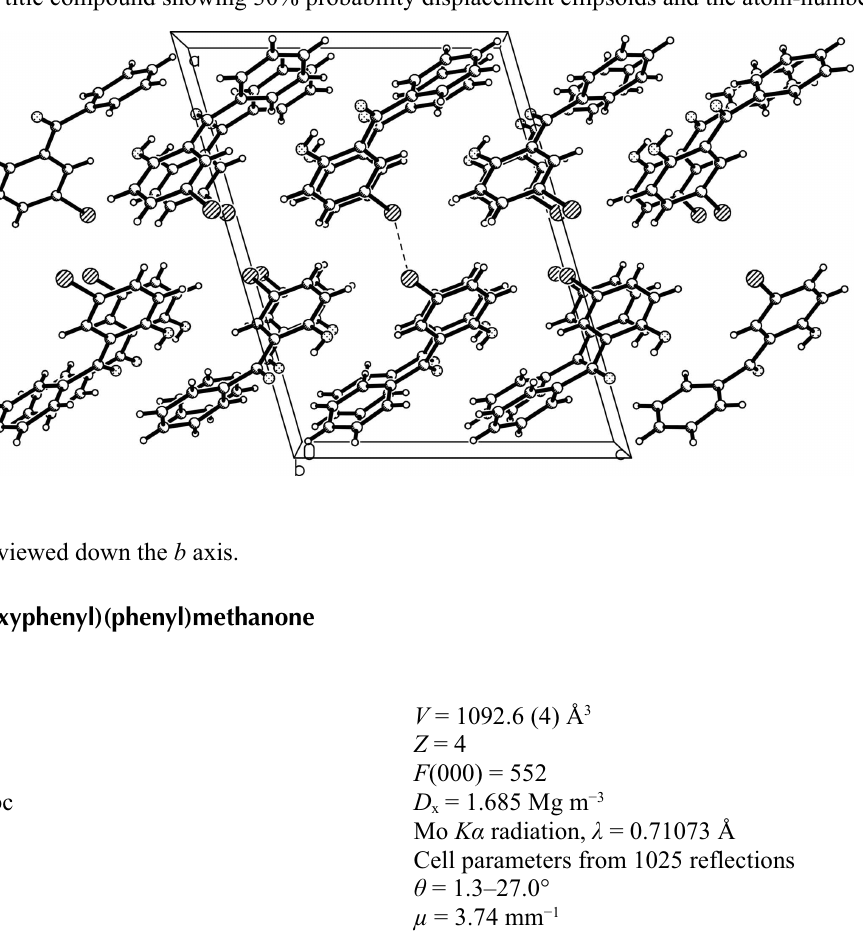
The structure of the title compound showing 30% probability displacement ellipsoids and the atom-numbering scheme.